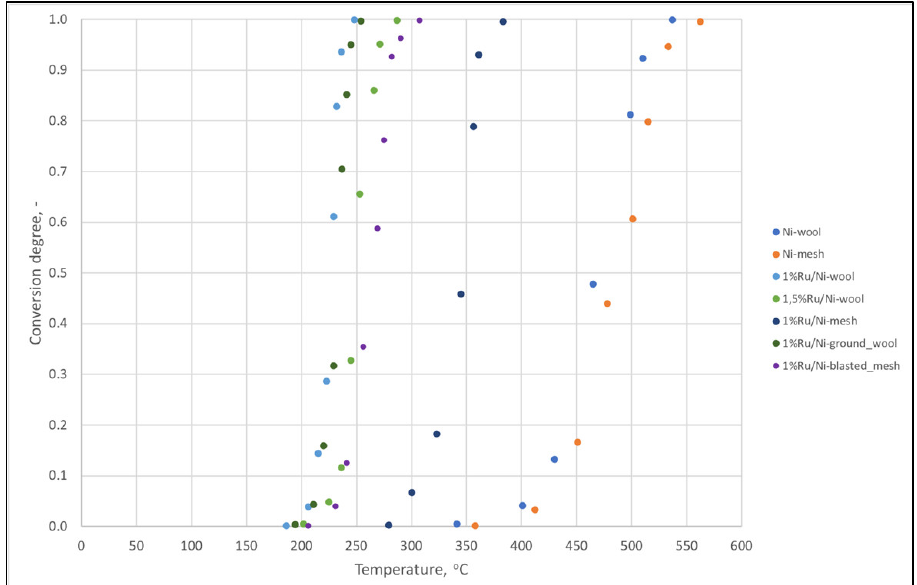
Figure 6. CO 2 conversion of catalysts made of nickel wool or nickel mesh and ornamented with ca. 1% nano-Ru, -Re, -Pd, or -Au.